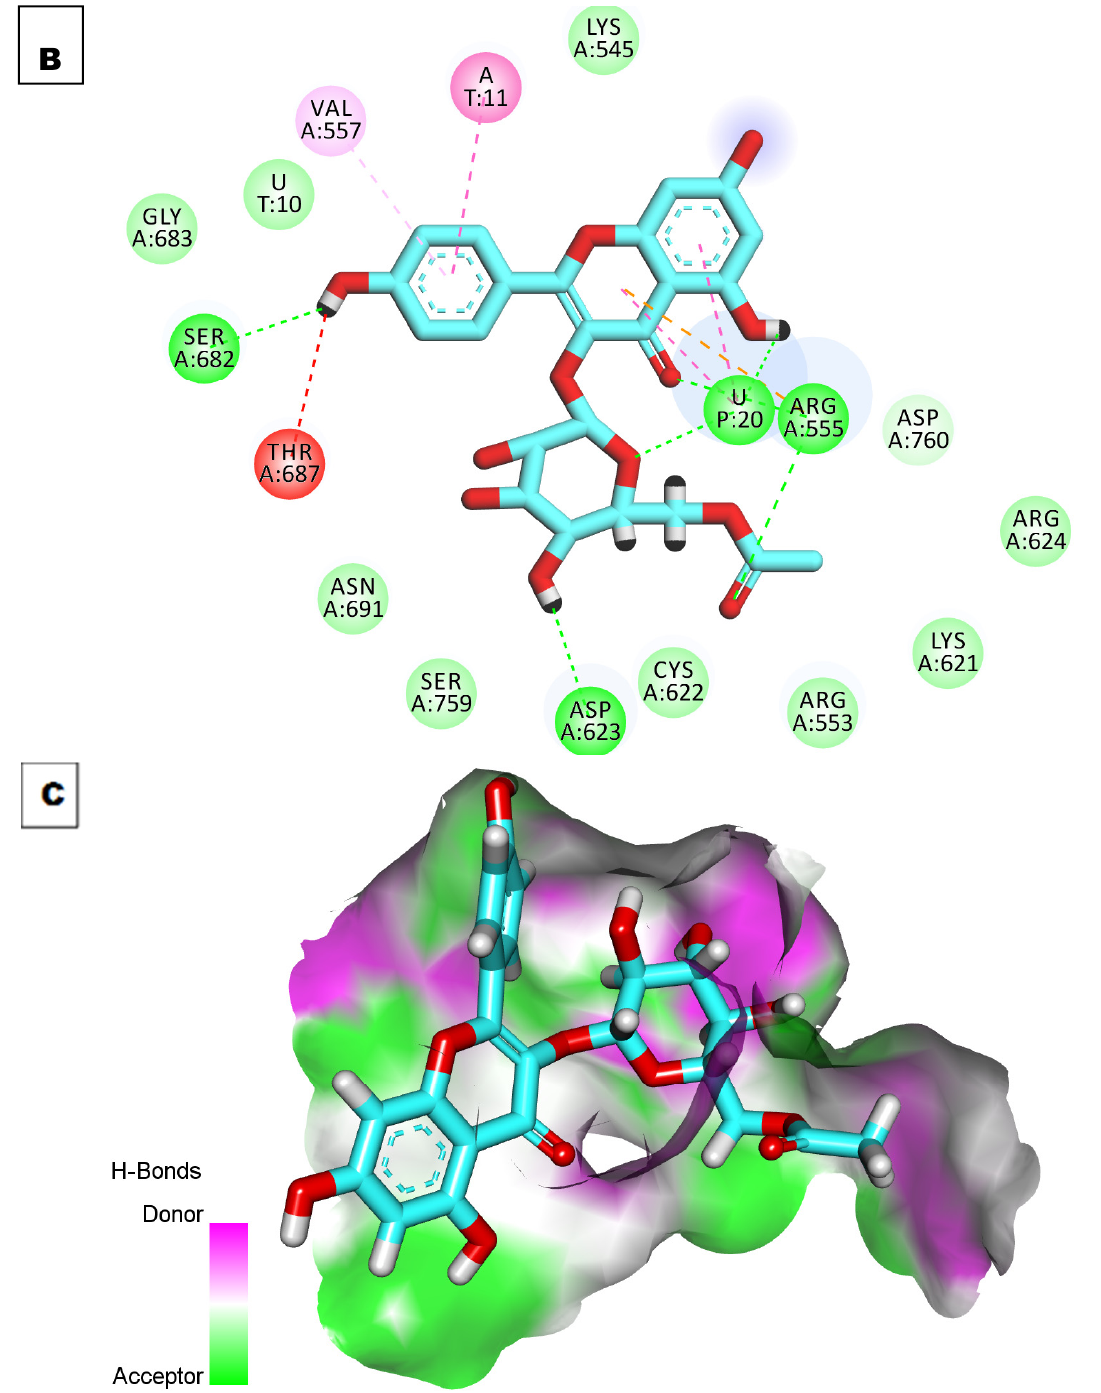
Figure 7. ( A ) 3D image ( B ) 2D image, and ( C ) surface mapping of K3G-A docked into the active site of RdRp.